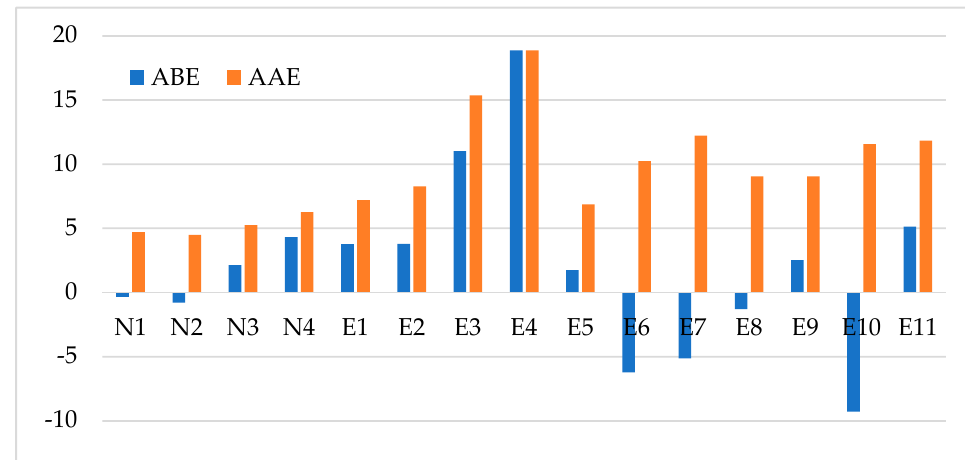
Figure 4. AAE and ABE comparison using the new and existing HHV models.